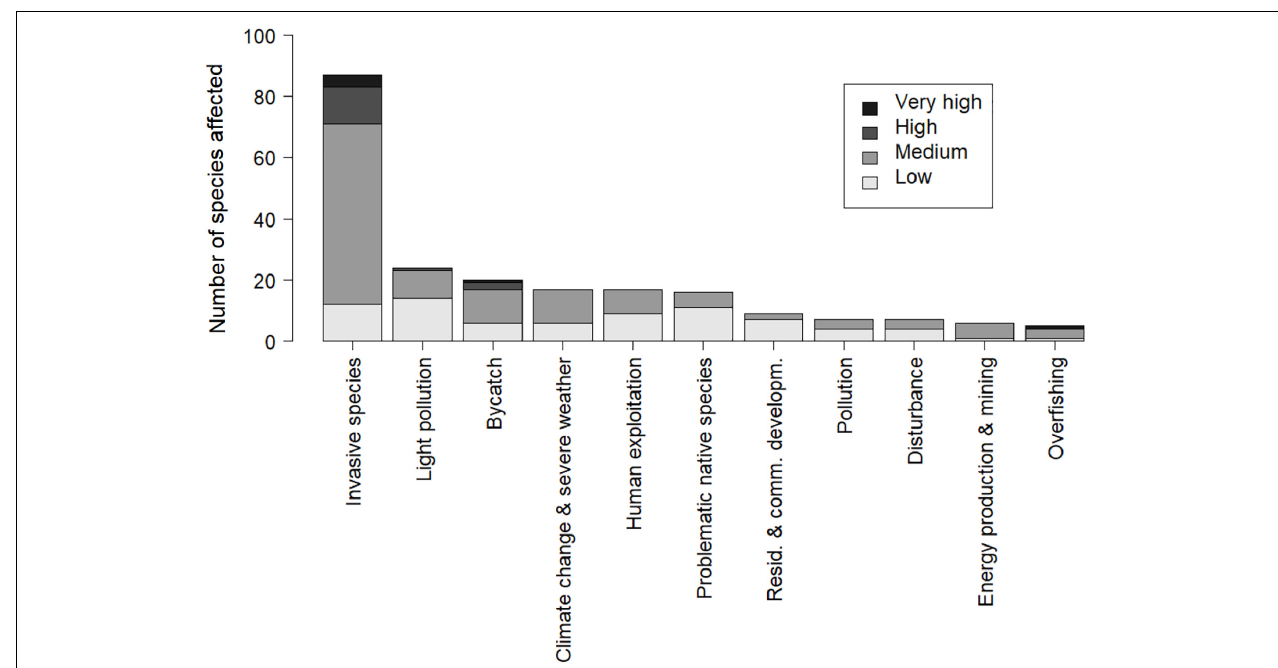
FIGURE 2 | Threats to petrels sorted by the number of species affected according to BirdLife International (2018a).